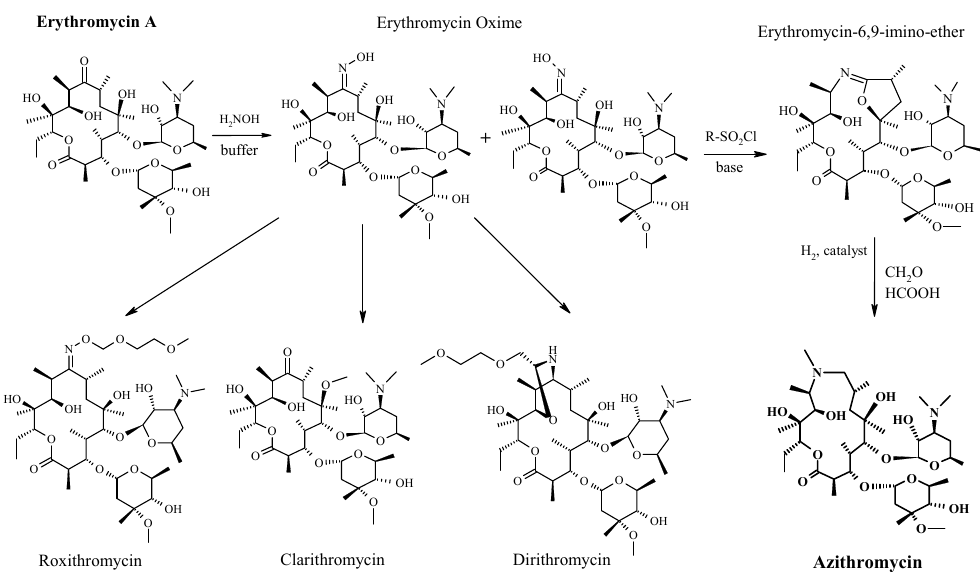
Figure 2. From Erythromycin A to other macrocyclic antibiotics (roxithromycin, dirithromycin, clarithromycin, etc.), including azithromycin, a “blockbuster” anti ‐ infective drug [31]. The first 15 ‐ membered macrolide antibiotic on the market—azithromycin